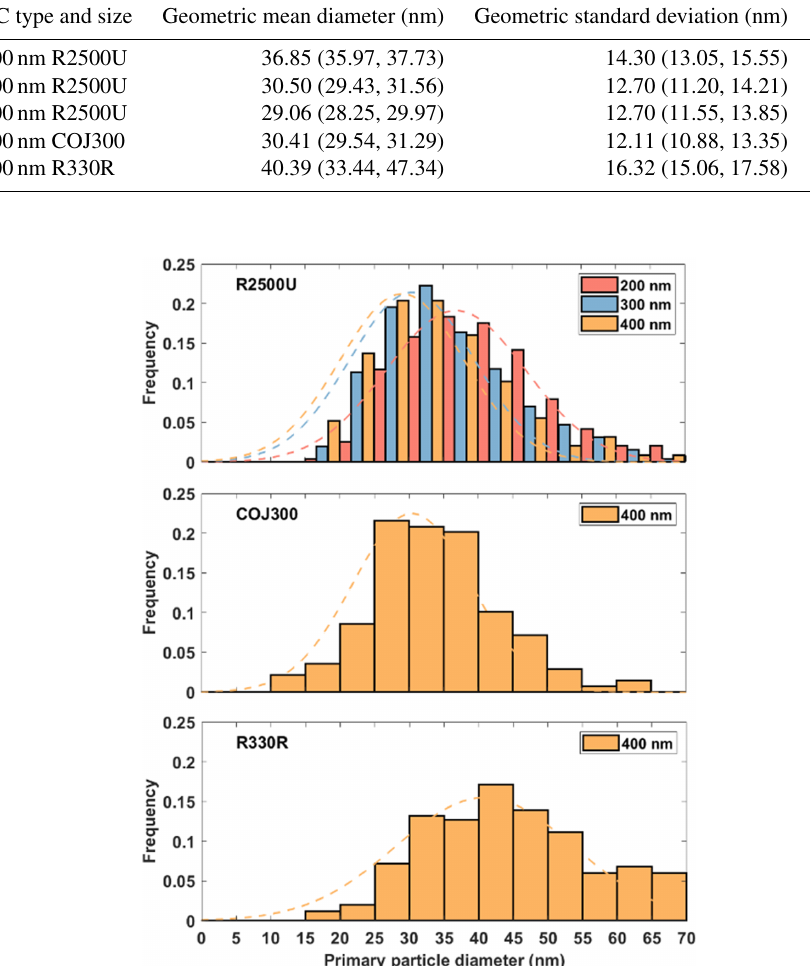
Figure A5. Primary particle size distributions for the selected BC particle types. The dashed lines are the fitted normal distribution